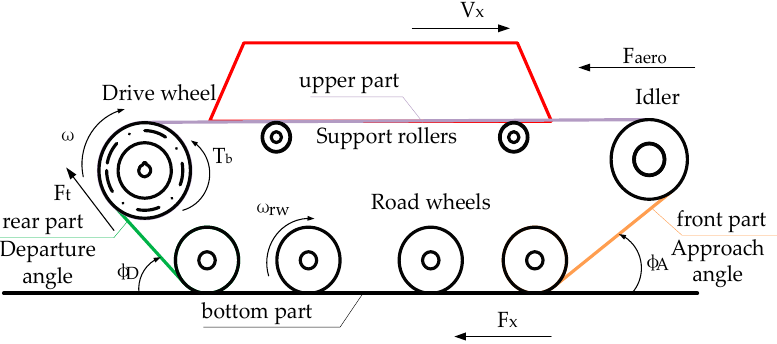
Figure 2. Schematic diagram of force and torques acting on a DDTV when braking.